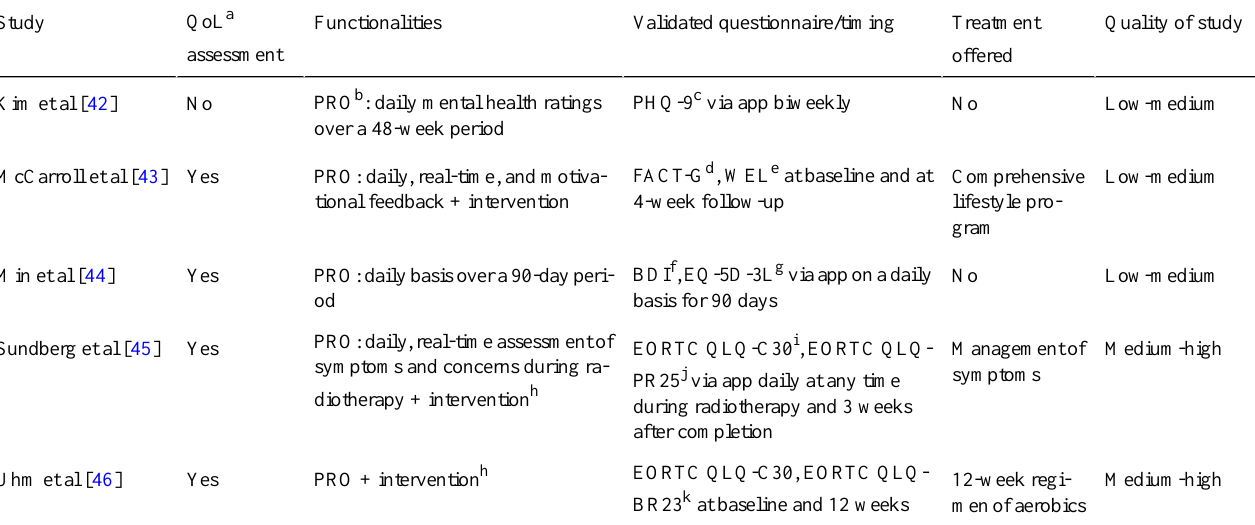
Table 2. Clinical characteristics of included studies